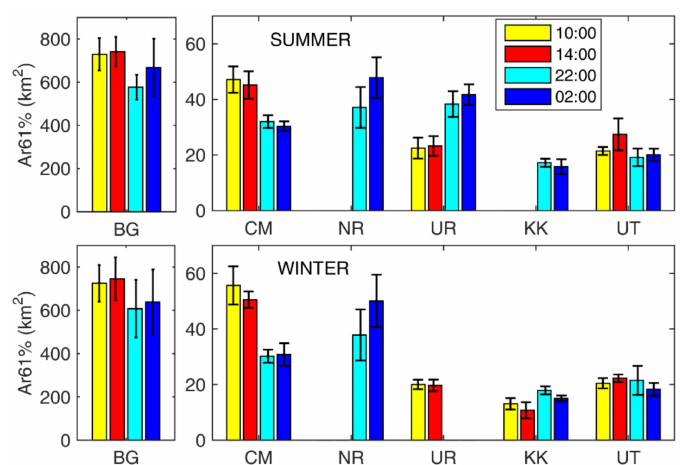
Figure 7. Intercity comparison of Gaussian footprint area Ar61% (km 2 ) during summer ( upper panel ) and winter ( bottom panel ). Ar61% is averaged over the 14 years, considering the diurnal variation at 10:00, 14:00, 22:00, and 02:00. The black bar is the standard deviation across the years.